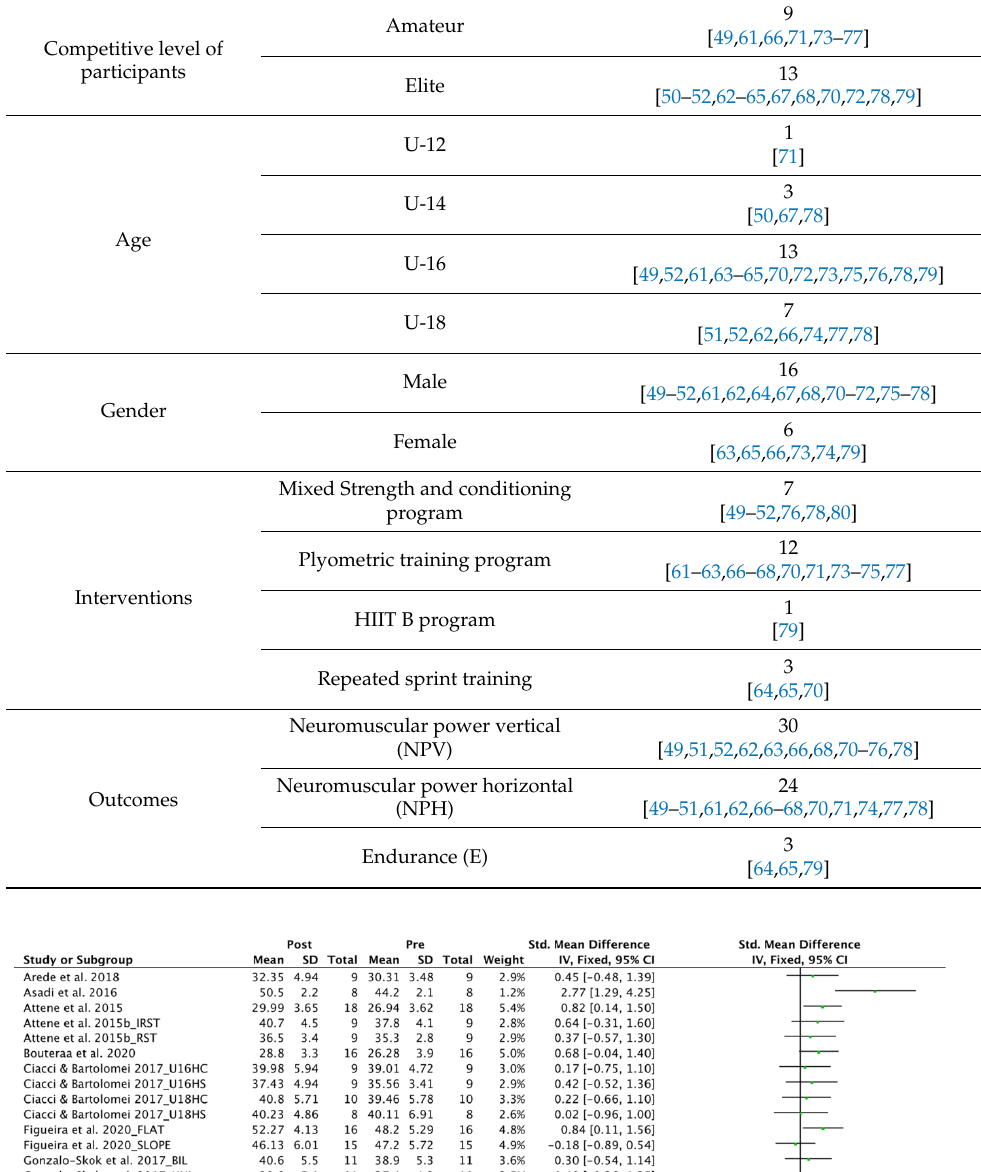
Table 3. Number studies included in the meta-analysis per sub-group and references.